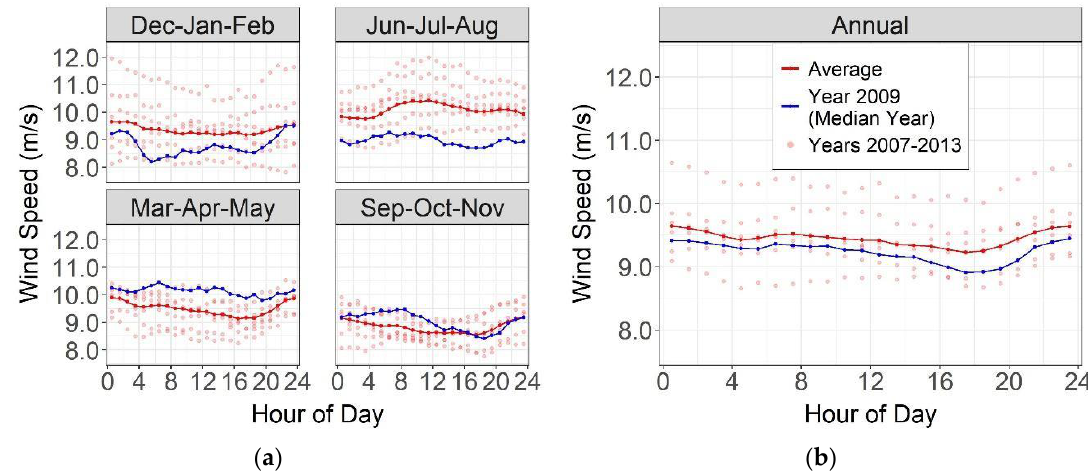
Figure 8. Daily profile of average wind speed by season ( a ) and for the year ( b ) for the Humboldt Call Area. The dots represent data averaged for each of the seven years with the average and median years highlighted in red and blue, respectively.